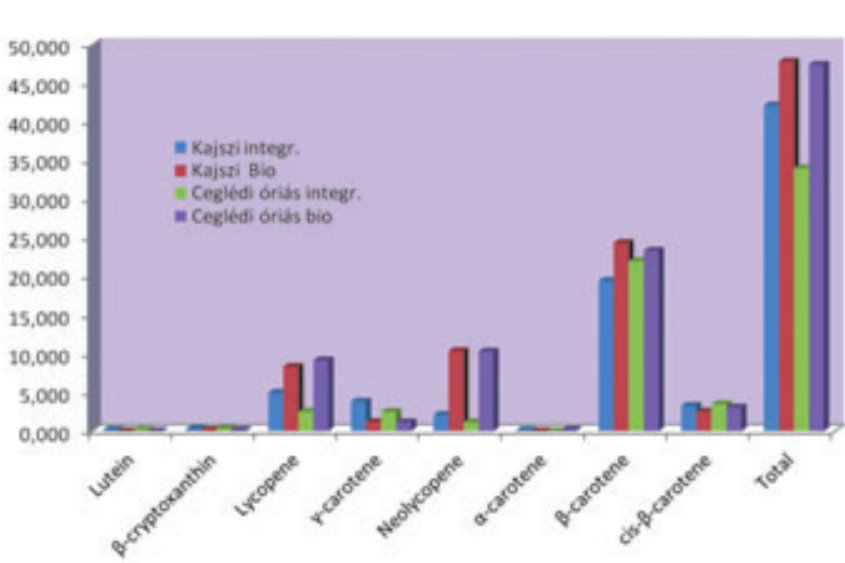
Bergarouge Integr.